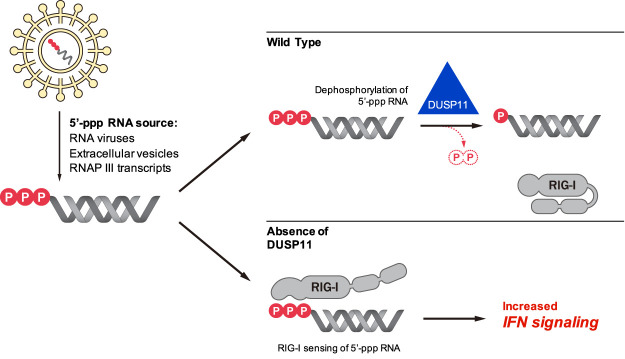
Model for DUSP11-mediated regulation of RIG-I signaling. The RNA triphosphatase DUSP11 dephosphorylates endogenous host and exogenous viral 5′-triphosphate RNAs and reduces the sensitivity of the RIG-I signaling response to these RNAs. The higher proportion of 5′-triphosphate RNAs in the absence of DUSP11 results in aberrant RIG-I sensing and increased interferon signaling.